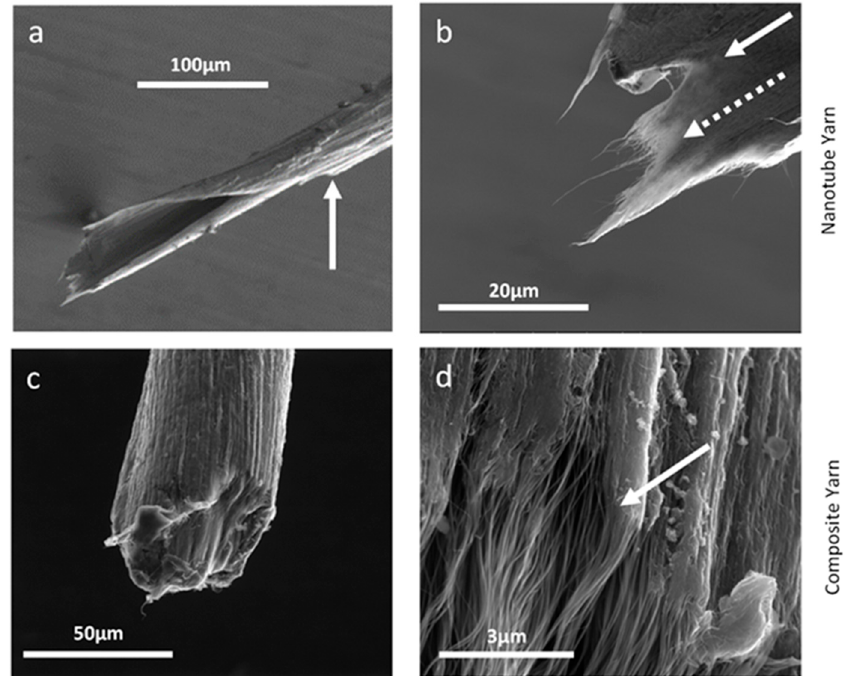
Figure 9. Fracture surface investigation performed by SEM. ( a ) Twisted yarn with the damage extending ~250 µ m to the point indicated by the arrow. ( b ) Tip of the twisted yarn with the pull-out feature (dotted arrow) and the undisturbed structure (solid arrow). ( c ) Composite yarn with ~25 µ m damage region. ( d ) Tip of the composite yarn, with arrow showing end of the resin with much smaller scale pull-out.